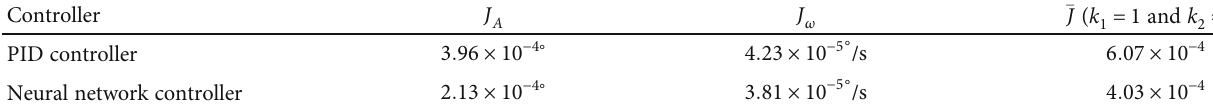
Table 8: Performances of staring at the central ground target.